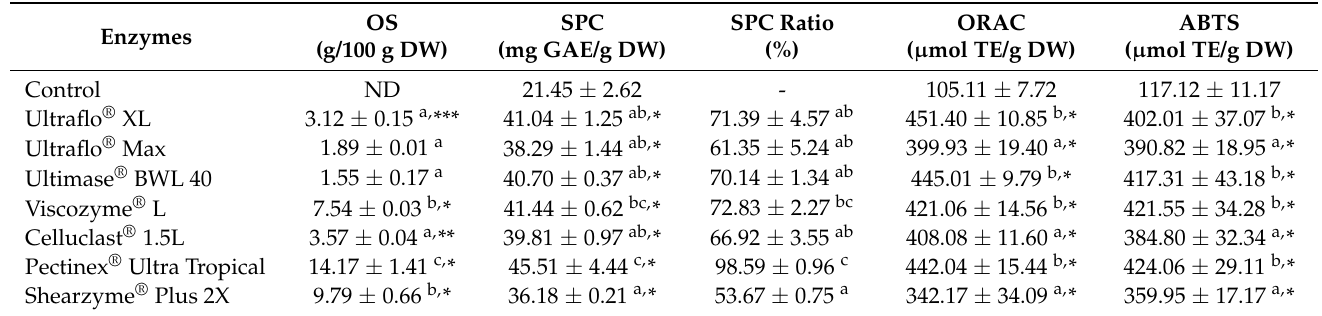
Table 2. Oligosaccharides and soluble phenolic compound release and antioxidant activity in hy- drolyzed lentil seed coats treated by seven commercial food-grade